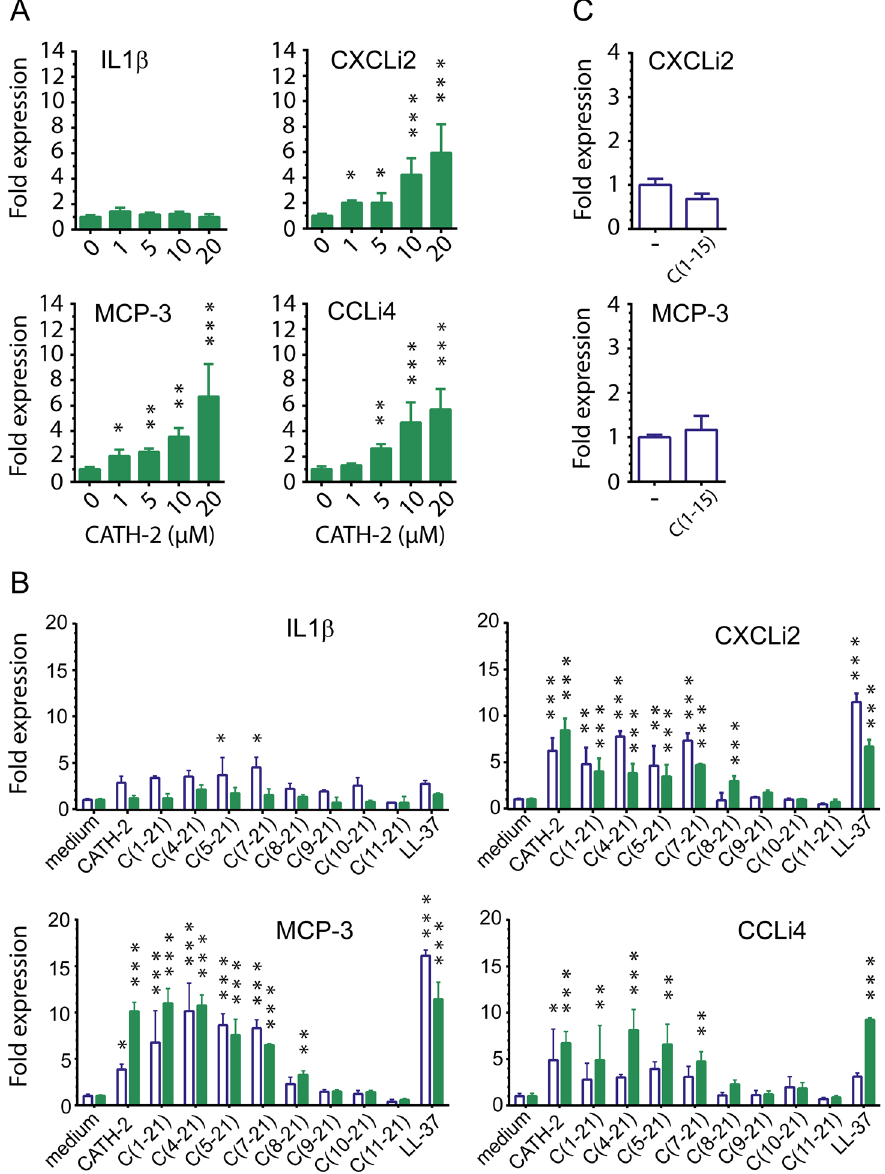
Fig 3. Induction of chemokine transcription in HD11 cells by truncated CATH-2 analogs. CXCLi2, MCP-3, CCLi4 and IL-1 β transcription in HD11 cells treated with CATH-2 derived peptides (1 to 20 μ M). Transcription was measured by real time QPCR analysis after 4 h (open bars) or 24 h (closed bars) of stimulation. a CATH-2 dose-dependently induced transcription of chemokines chCXCLi2/IL-8, MCP-3 and chCCLi4/RANTES, but not of pro-inflammatory cytokine IL-1 β . b The capacity to induce chemokine transcription was maintained for N-terminally truncated C(1 – 21) analogs up to 14 amino acid residues during 24 h exposure. c No chemokine induction was observed when cells were exposed (4 h) to peptide C(1 – 15). Data from 3 to 4 independent experiments; means ± SEM * p < 0.05, ** p < 0.01, *** p <